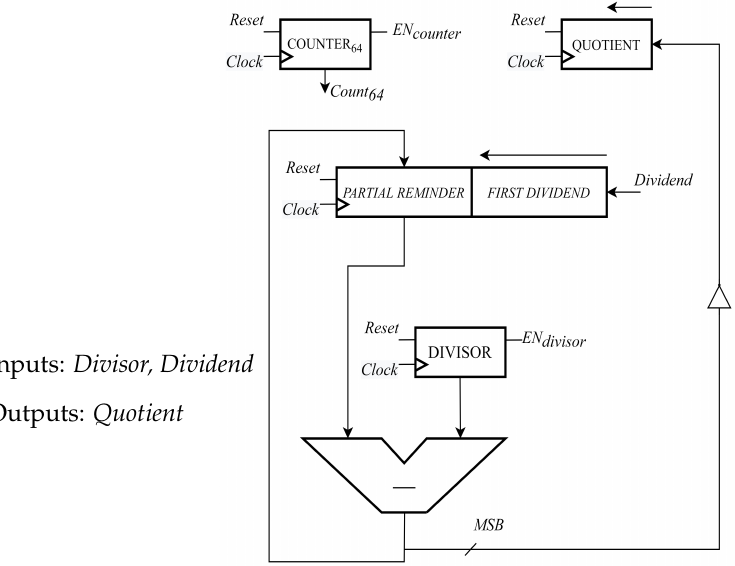
Figure 7. Optimized division data path.